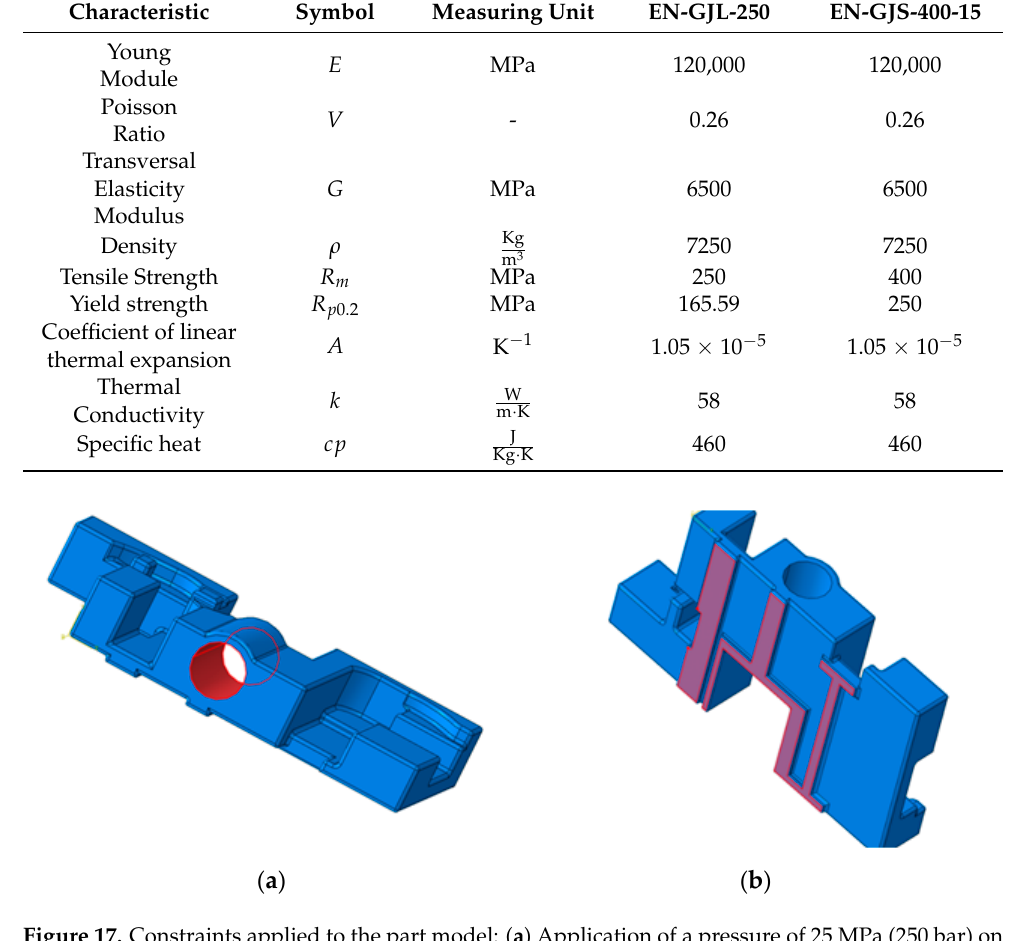
Figure 17. Constraints applied to the part model: ( a ) Application of a pressure of 25 MPa (250 bar) on the inner surface of the hydraulic cylinder; ( b ) Application of the kinematic constraints of embedding type which materialize the fixing of the hydraulic block on the support.